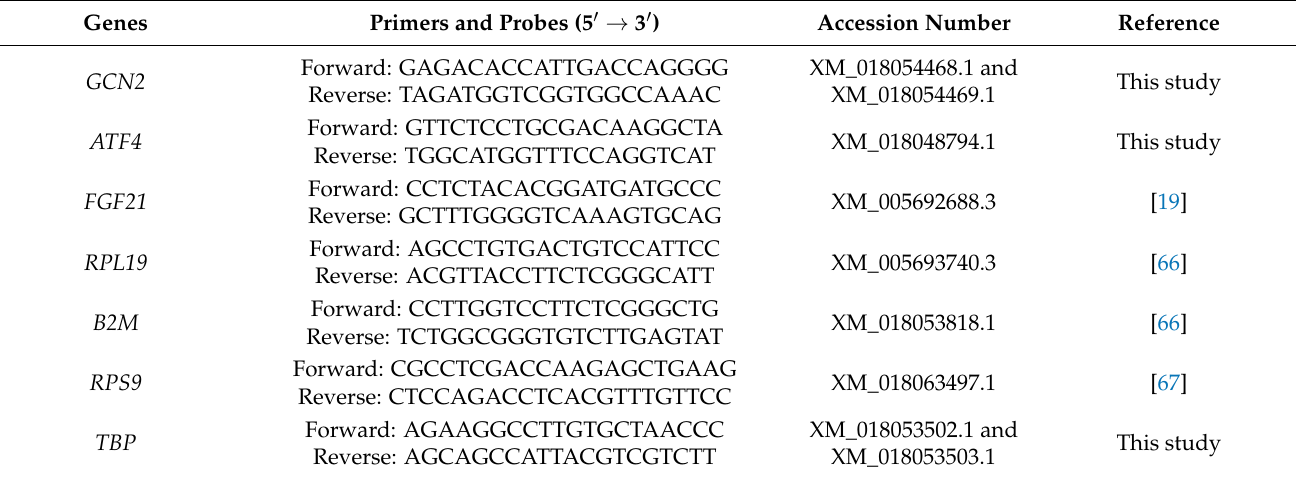
Table 10. Primers used for SYBR green